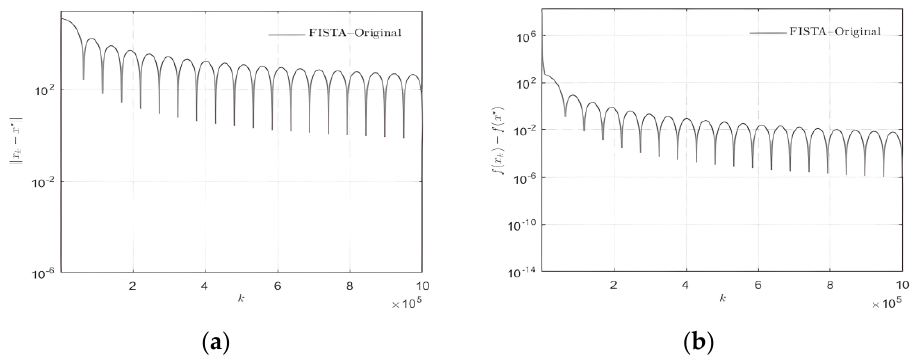
Figure 2. Iteration of conventional FISTA. ( a ) || x k − x ∗ || . It depicts the reconstruction error diagram of x k and x ∗ in each iterative process under the traditional fast iterative soft threshold algorithm; ( b ) f ( x k ) − f ( x ∗ ) shows the difference between the value of x k obtained in each iteration and x ∗ in solving the lasso problem shown in Formula